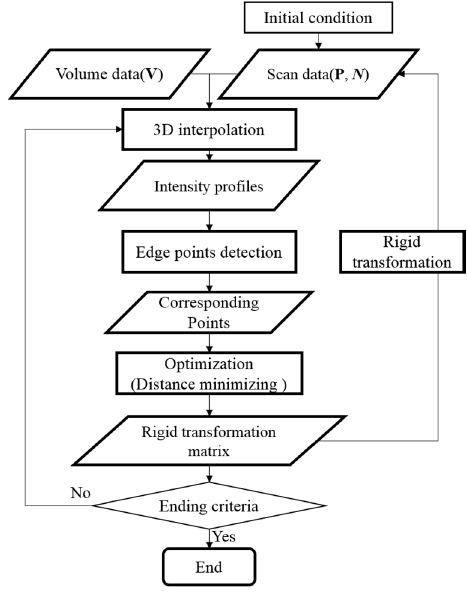
Figure 3. Overall procedure of the proposed method.